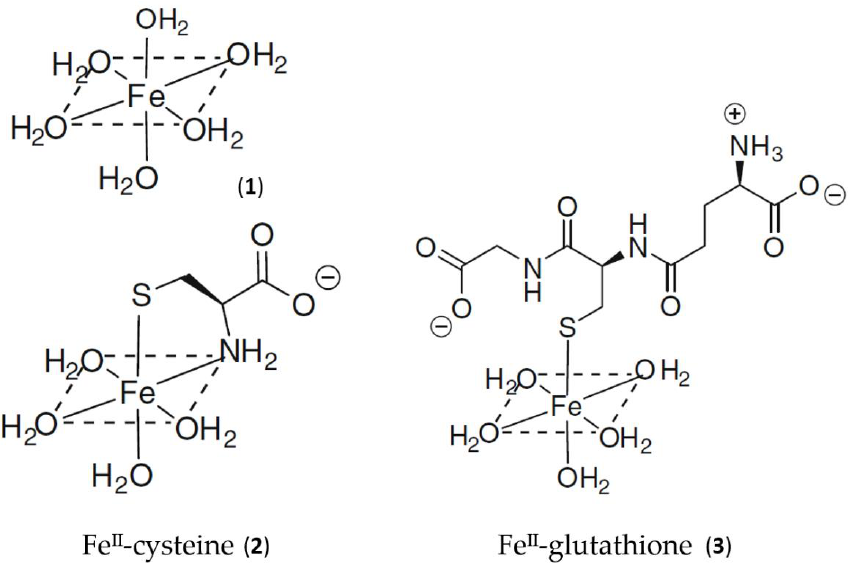
Scheme 1. Schematic structure of the aqueous, cysteine, and glutathione complexes with iron(II). ( 1 ) Hexaaquo·iron(II); ( 2 ) iron(II)cysteine complex; ( 3 ) iron(II)glutathione.